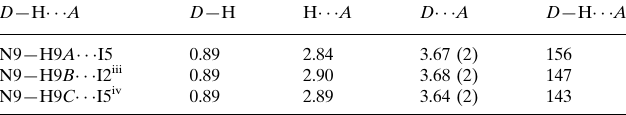
Hydrogen-bond geometry (A˚ , (cid:4)